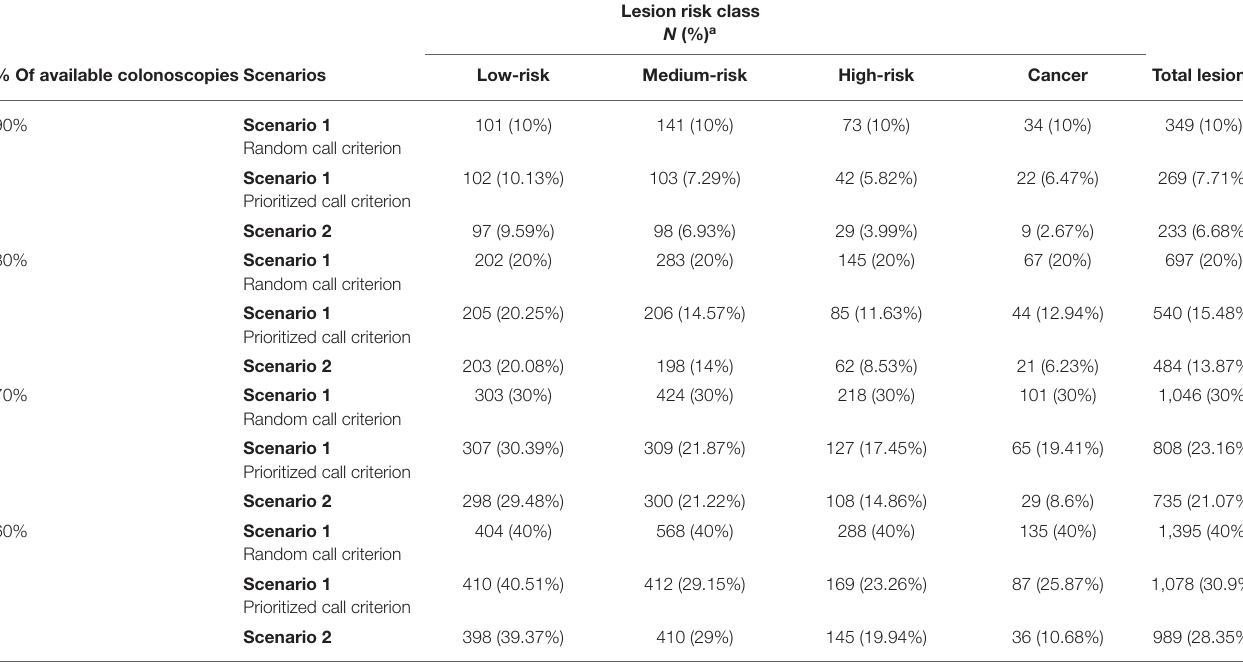
Lesion risk class N (%) a